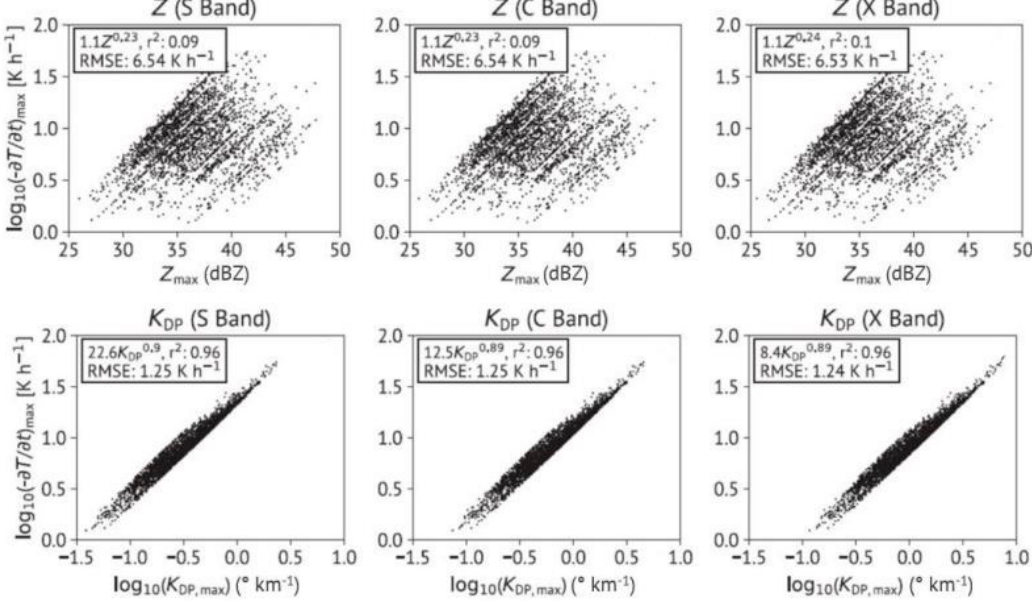
Figure 21. ( Top panels ) Scatterplots of the maximal simulated cooling rates versus maximal Z within the melting layers for various size distributions of snow above the melting layers at the S, C, and X bands. ( Bottom panels ) Scatterplots of the maximal simulated cooling rate versus the maximal K DP within the melting layers for various size distributions of snow above the melting layers at the S, C, and X bands. Adapted from Carlin and Ryzhkov